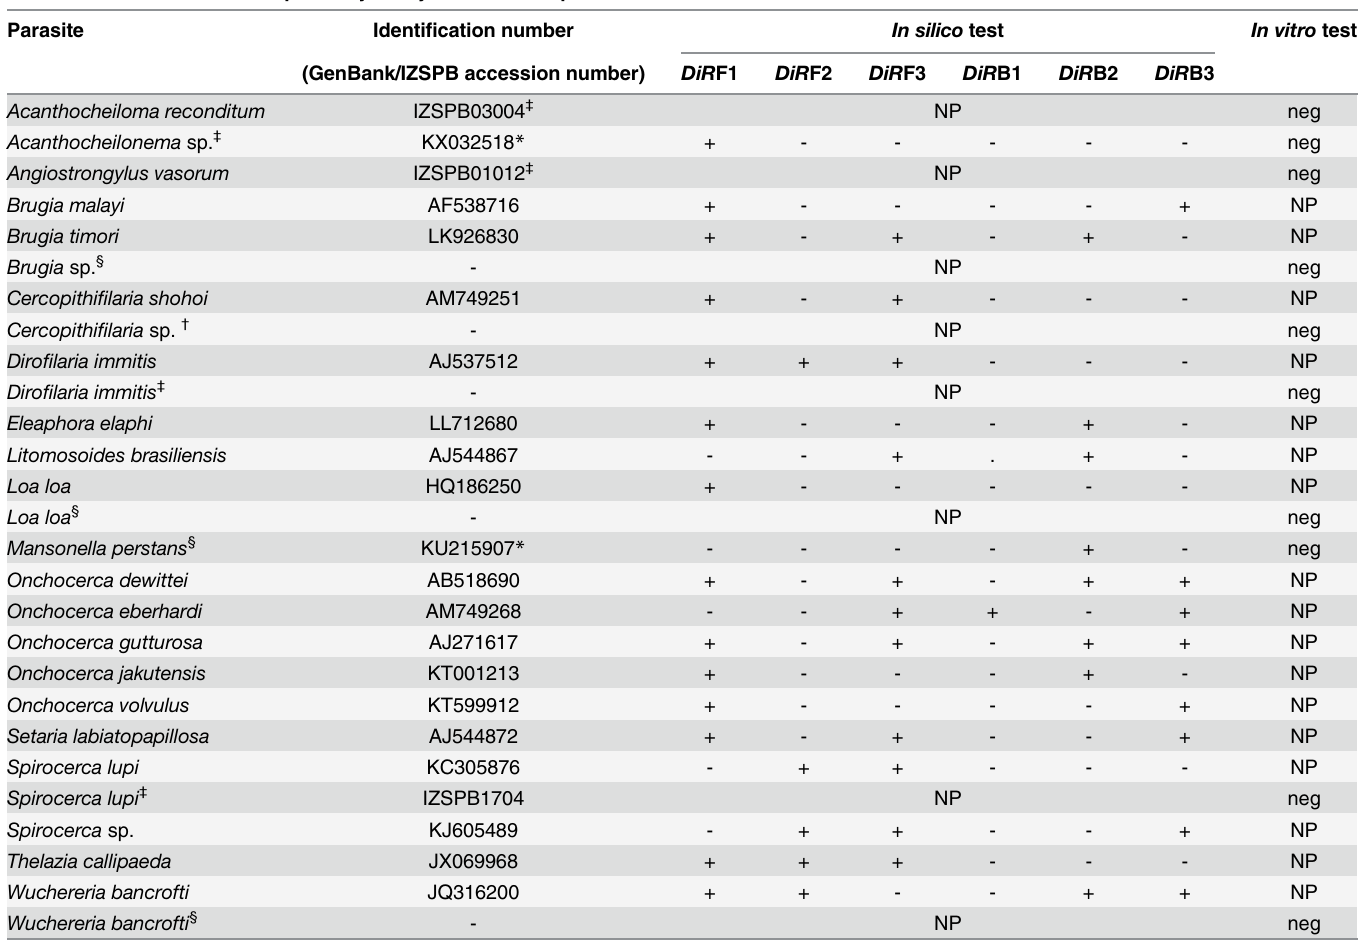
Table 2. Parasites tested for specificity assays and their respective